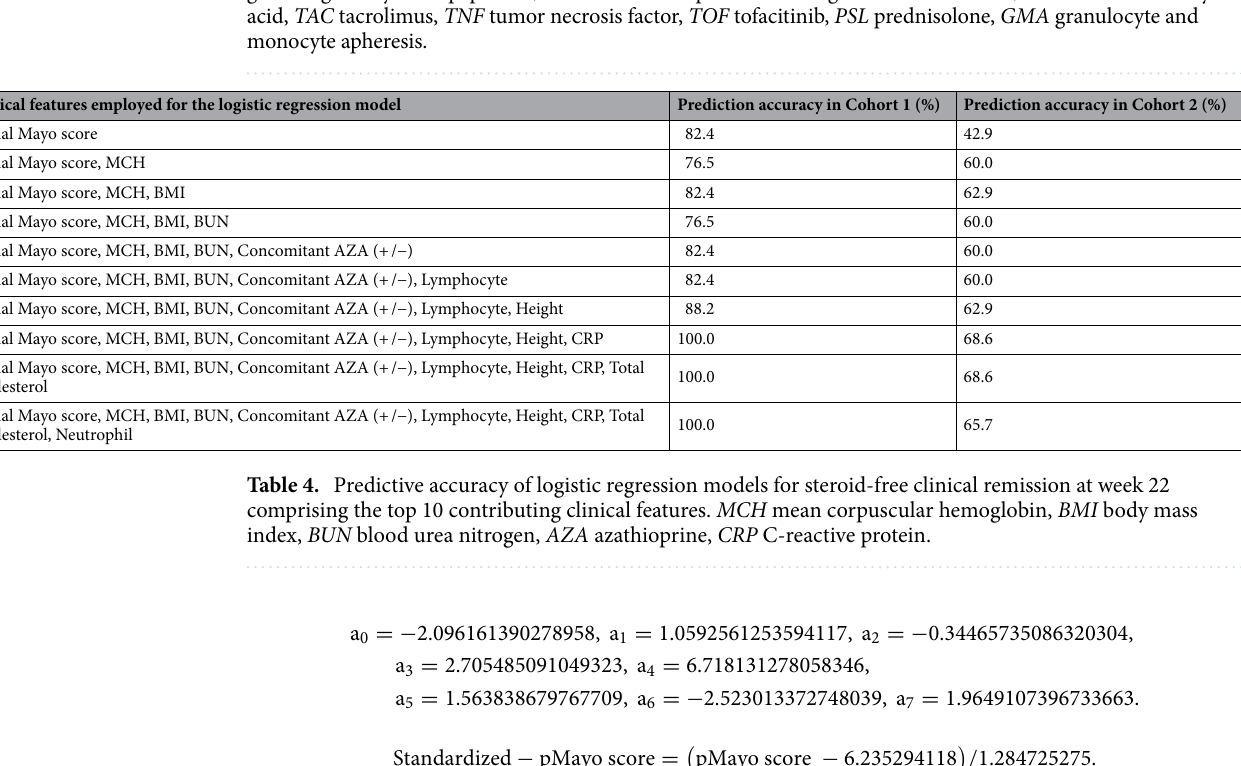
Figure 1. Contributions of 49 clinical features at week 0 to the likelihood of steroid-free clinical remission (SFCR) at week 22. The contribution of each baseline clinical feature to SFCR at week 22 was determined using the random forest algorithm. MCH mean corpuscular hemoglobin, BMI body mass index, BUN blood urea nitrogen, AZA azathioprine, CRP C-reactive protein, MCV mean corpuscular volume, UCEIS ulcerative colitis